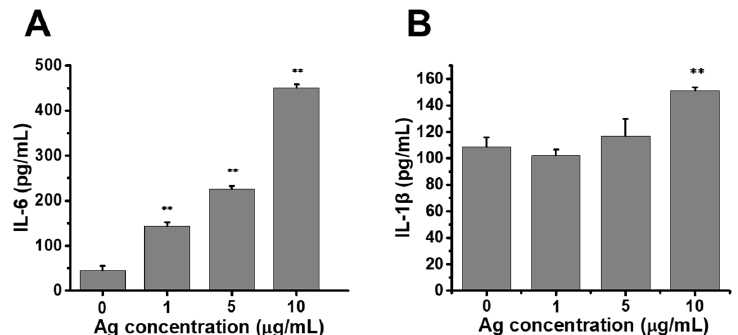
Figure 5. The secretion of inflammatory cytokines enhanced by Au@Ag NRs in Raw264.7 cells. ( A ) the secretion of IL-6, after 24 h exposure to Au@Ag NRs; ( B ) the IL-1 β level in cultural supernatant. The * represents significant difference from control group (**: p < 0.01). The data were presented as mean ± SD ( n = 3).